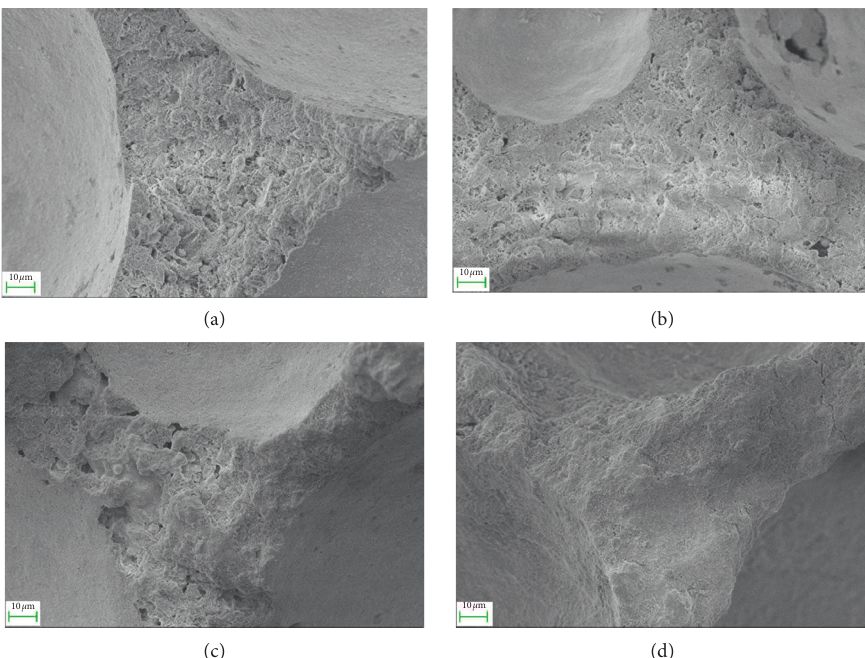
Figure 13: The SEM photographs of foamed concrete structures (28d): (a) standard curing conditions (pure cement), (b) temperature- matched curing conditions (pure cement), (c) standard curing conditions (containing fly ash), and (d) temperature-matched curing conditions (containing fly